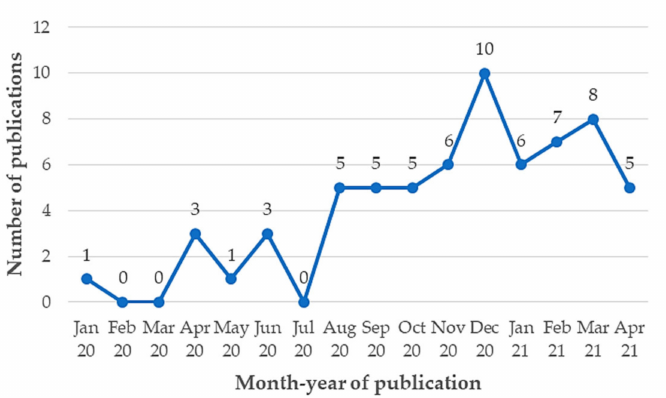
Figure 6. Number of papers evidencing the use of process improvement approaches for ramping up the response of EDs against COVID-19 (Period: January 2020–April 2021).